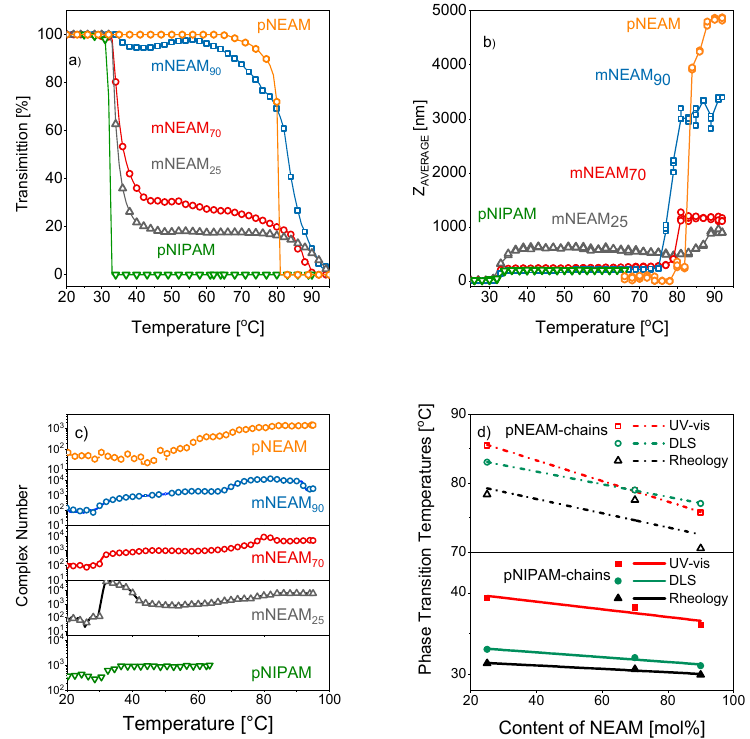
Figure 2. Phase transition temperatures analyzed for all the blends composed of pure polymers by UV-vis spectroscopy [1wt.%] ( a ), dynamic light scattering [0.03wt.%] ( b ), and rheology [10wt.%] ( c ). LCSTs of pNEAM and pNIPAM vs. pNEAM-content ( d ).